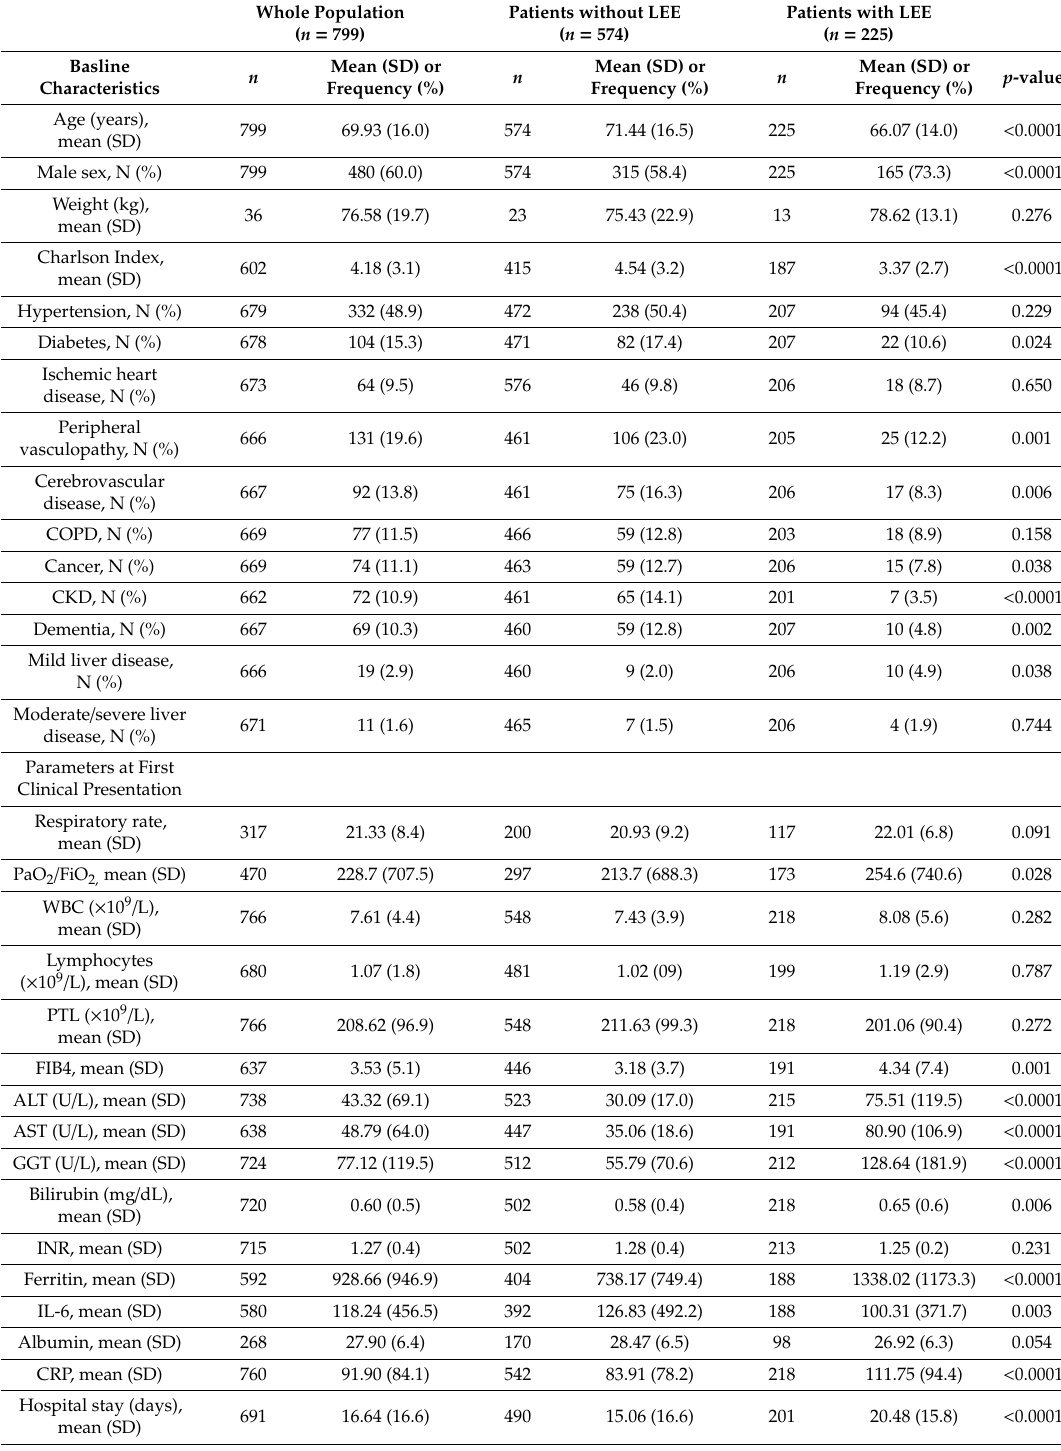
Table 2. Baseline characteristics of patients included in the study according to liver enzyme elevation (LEE) grade ≥ 2 development in the course of COVID-19. Whole Population Patients without LEE Patients with LEE ( n = 799) ( n = 574) ( n =